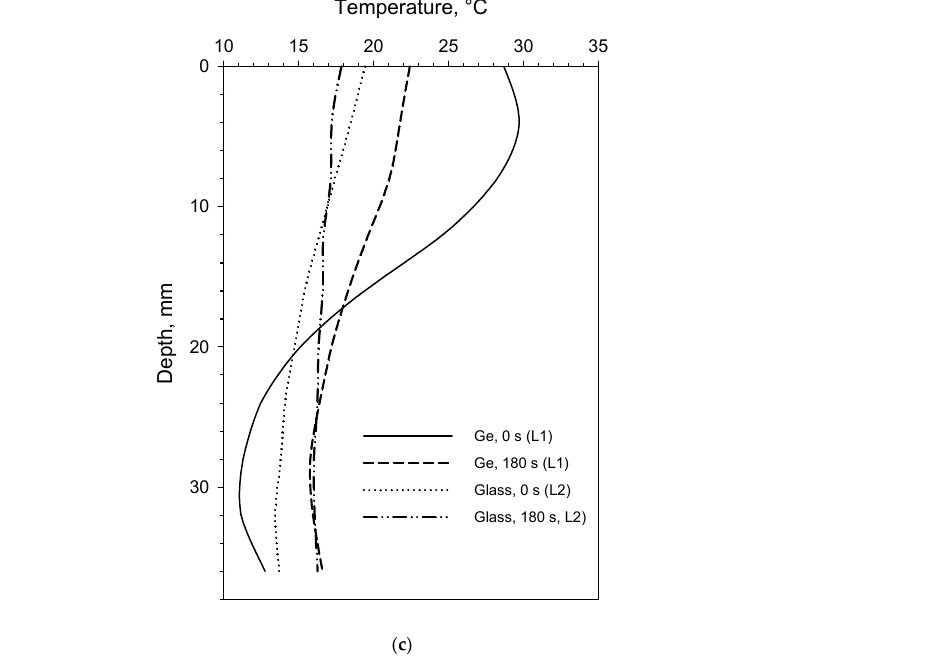
Figure 1. ( a ) Thermograms were recorded from above outside freeze-drier of the two cuvettes (IR mirror vaguely discernible in light green). For the cuvette on the left, the Ge-window was placed next to IR mirror, and on the right; the optical glass window was placed next to IR mirror. Both cuvettes were filled with 7.5 mL ice-water (3 ◦ C) and 2.5 mL warm olive oil (50 ◦ C). The thermogram was taken at 0 s for a 180-s measurement sequence. (Note that this set-up is rotated 180 ◦ in comparison with Figure 4a–c). ( b ) Thermogram of B270 soda-lime glass window (top) and germanium window (bottom) placed on top of two recipients filled with 25 ◦ C water (left) and 1 ◦ C ice water (right). A 2-cm gap of air was present between the windows and the water surfaces. ( c ) Temperature at 0 and 180 s, respectively, along depth profiles L1 and L2 in ( a ). The B270 soda-lime glass window is opaque to LWIR transmission in contrast to the Ge-window.